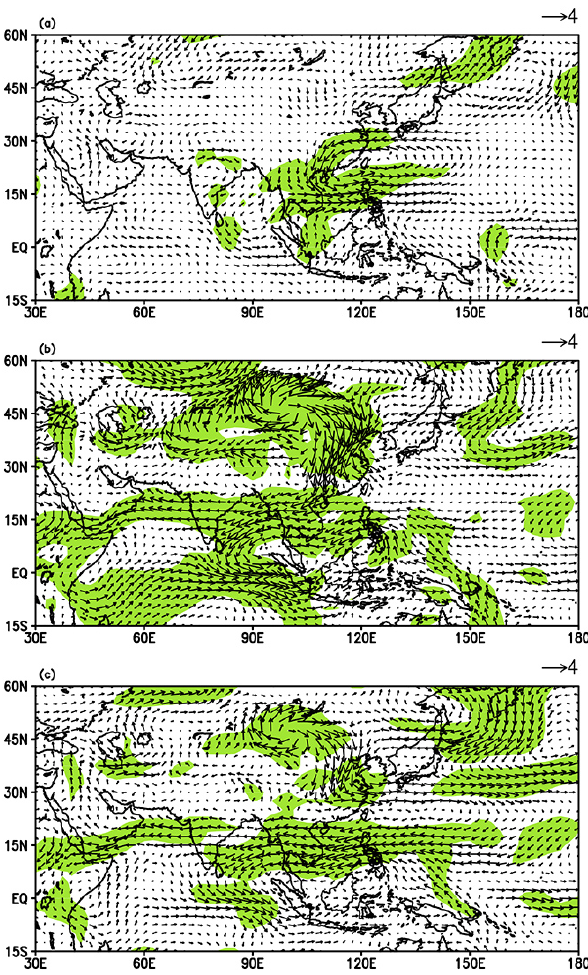
Figure 7. Same as Fig. 5 except for the moisture flux vectors verti- cally integrated from the surface to 300hPa (kgcm − 1 s − 1